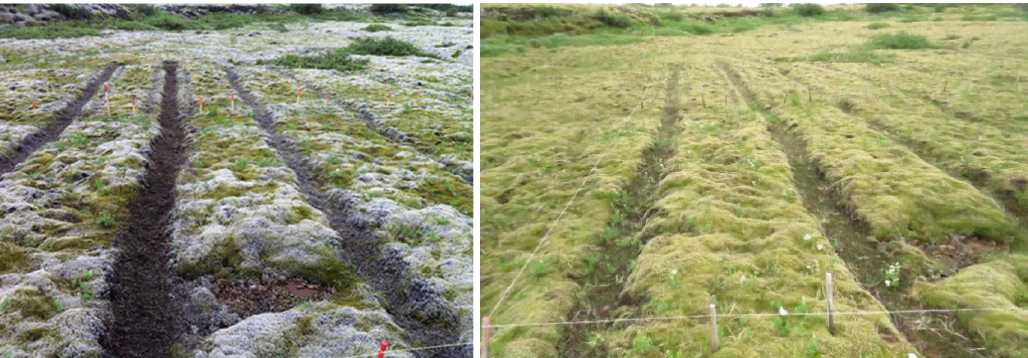
Figure 6. The Moss plot in Þingvellir National Park directly after trampling in 2014 ( left ). The same plot after two years (2016)—all trampling lanes are still clearly visible ( right ).